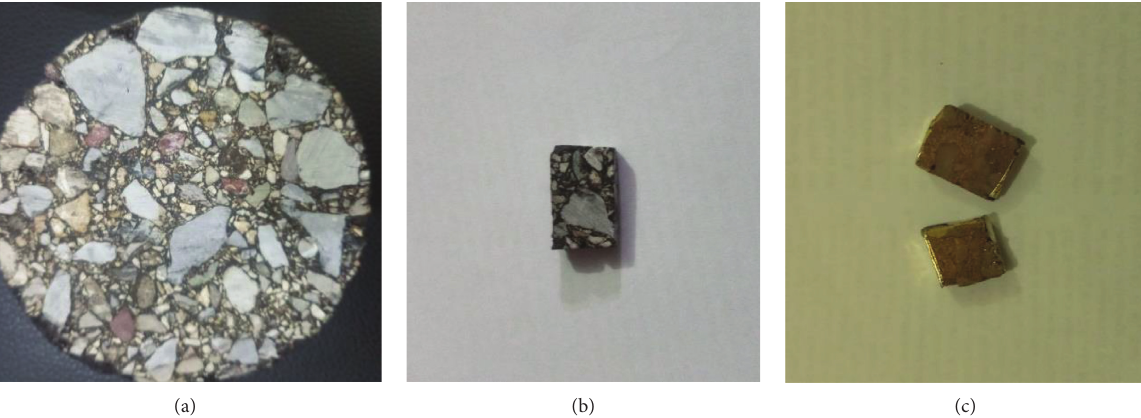
Figure 7: Sample preparation: (a) Marshall specimen, (b) specimen without coating, and (c) gold coated